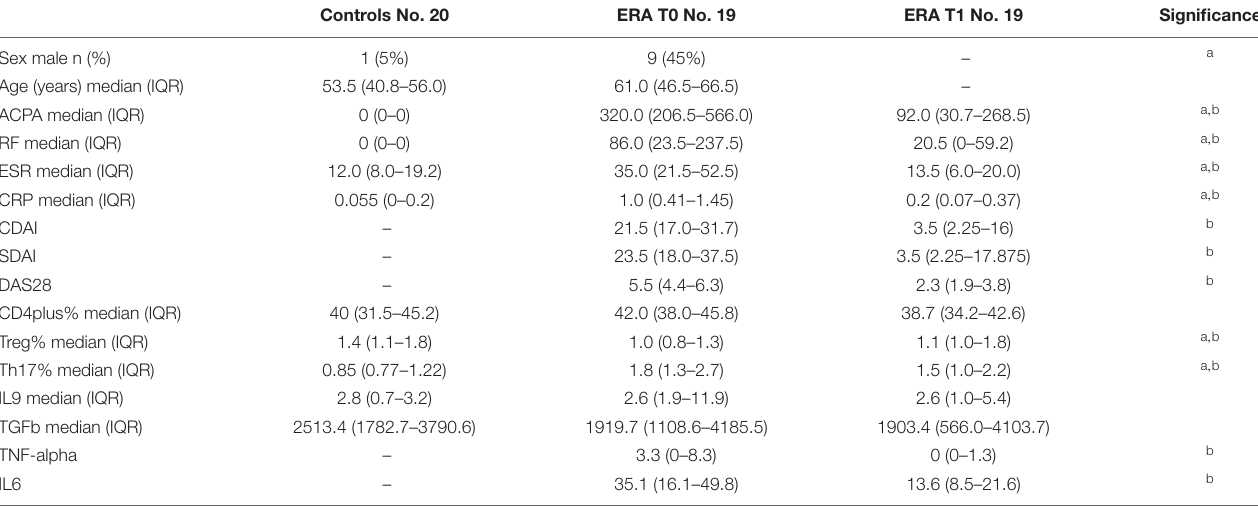
TABLE 1 | Demographic and clinical variables relative to the studied population of subjects. Controls No. 20 ERA T0 No. 19 ERA T1 No. 19